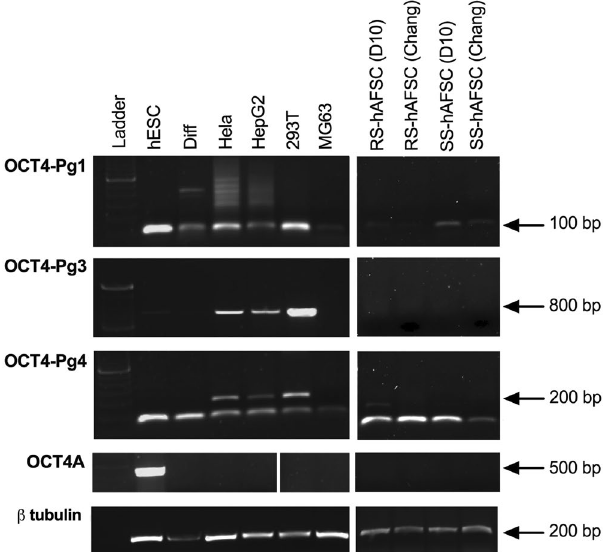
Figure 6. RT-PCR analysis for the housekeeping genes β tubulin, OCTA4-Pg1, OCT4-Pg3, OCT4-Pg4 and OCT4A expression in hESCs, differentiated cells, HeLa, HEPG2, 293T, MG63, and RS-hAFSCs and SS-hAFSCs cultivated in D10 or Chang medium. The image was overexposed to ensure that even faint bands were visible. Overexposure is visible in red on the